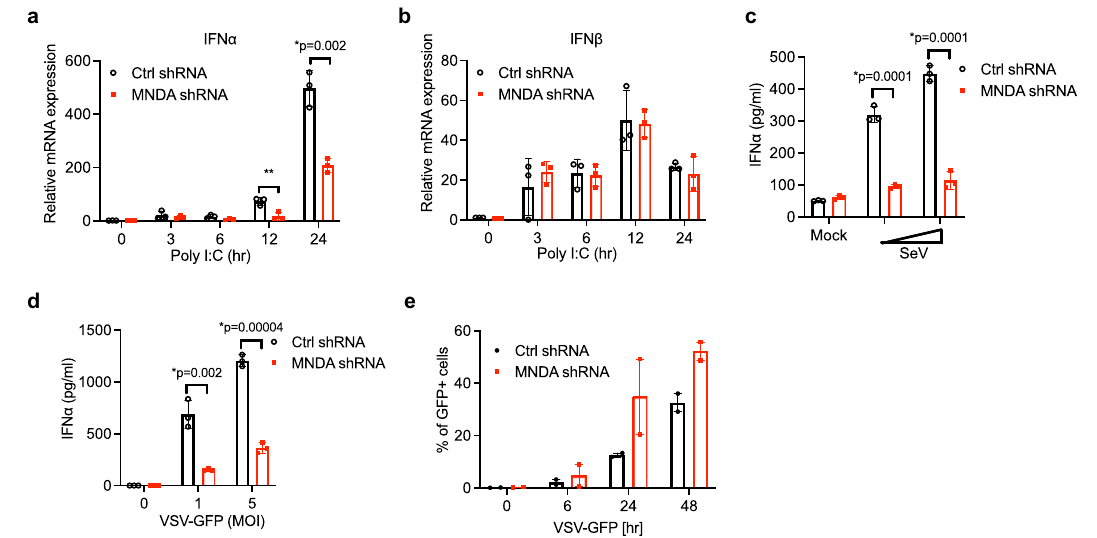
Fig. 2 MNDA regulates dsRNA- and virus-stimulated IFN α induction in monocytes. a , b Quantitative PCR analysis of IFN α ( a ) and IFN β ( b ) mRNA from THP-1 cells expressing control or MNDA shRNA transfected with poly(I:C) (2.5 μ g/ml) for the indicated times. c , d Release of IFN α protein from THP-1 cells expressing control or MNDA shRNA and infected with Sendai virus (SeV) for 24 h ( c ) or with VSV-GFP at the indicated MOI for 48 h ( d ). e Analysis of GFP protein expression by fl ow cytometry, as a measure of viral replication, in THP-1 cells expressing control or MNDA shRNA infected with VSV-GFP at an MOI of 5 for the indicated times. Data are mean ± SD of triplicate samples and are representative of three independent experiments ( a – d ) or are mean of two experiments ( e ); two tailed unpaired Students t test; * p < 0.05 indicates signi fi cance compared to respective groups; ns indicates not signi fi